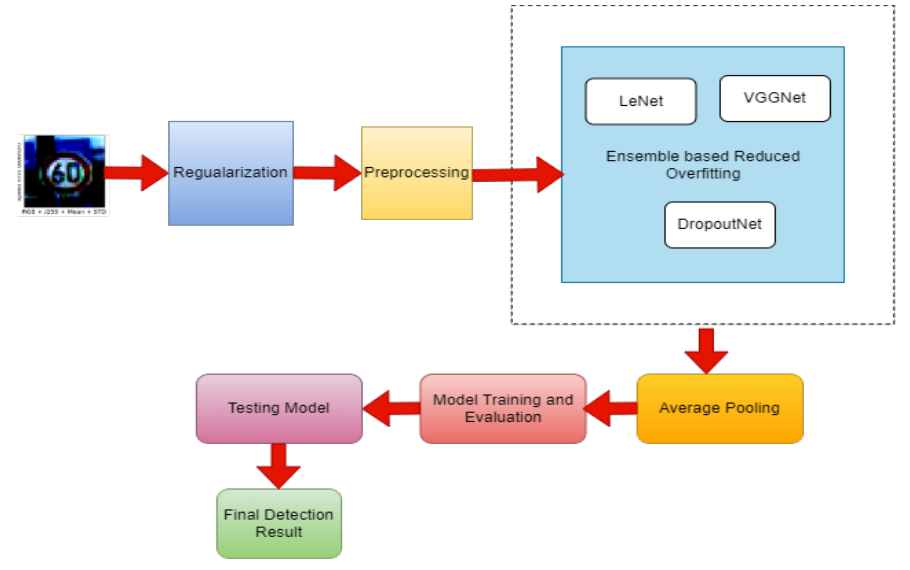
Figure 5. Proposed ELVD Diagram.